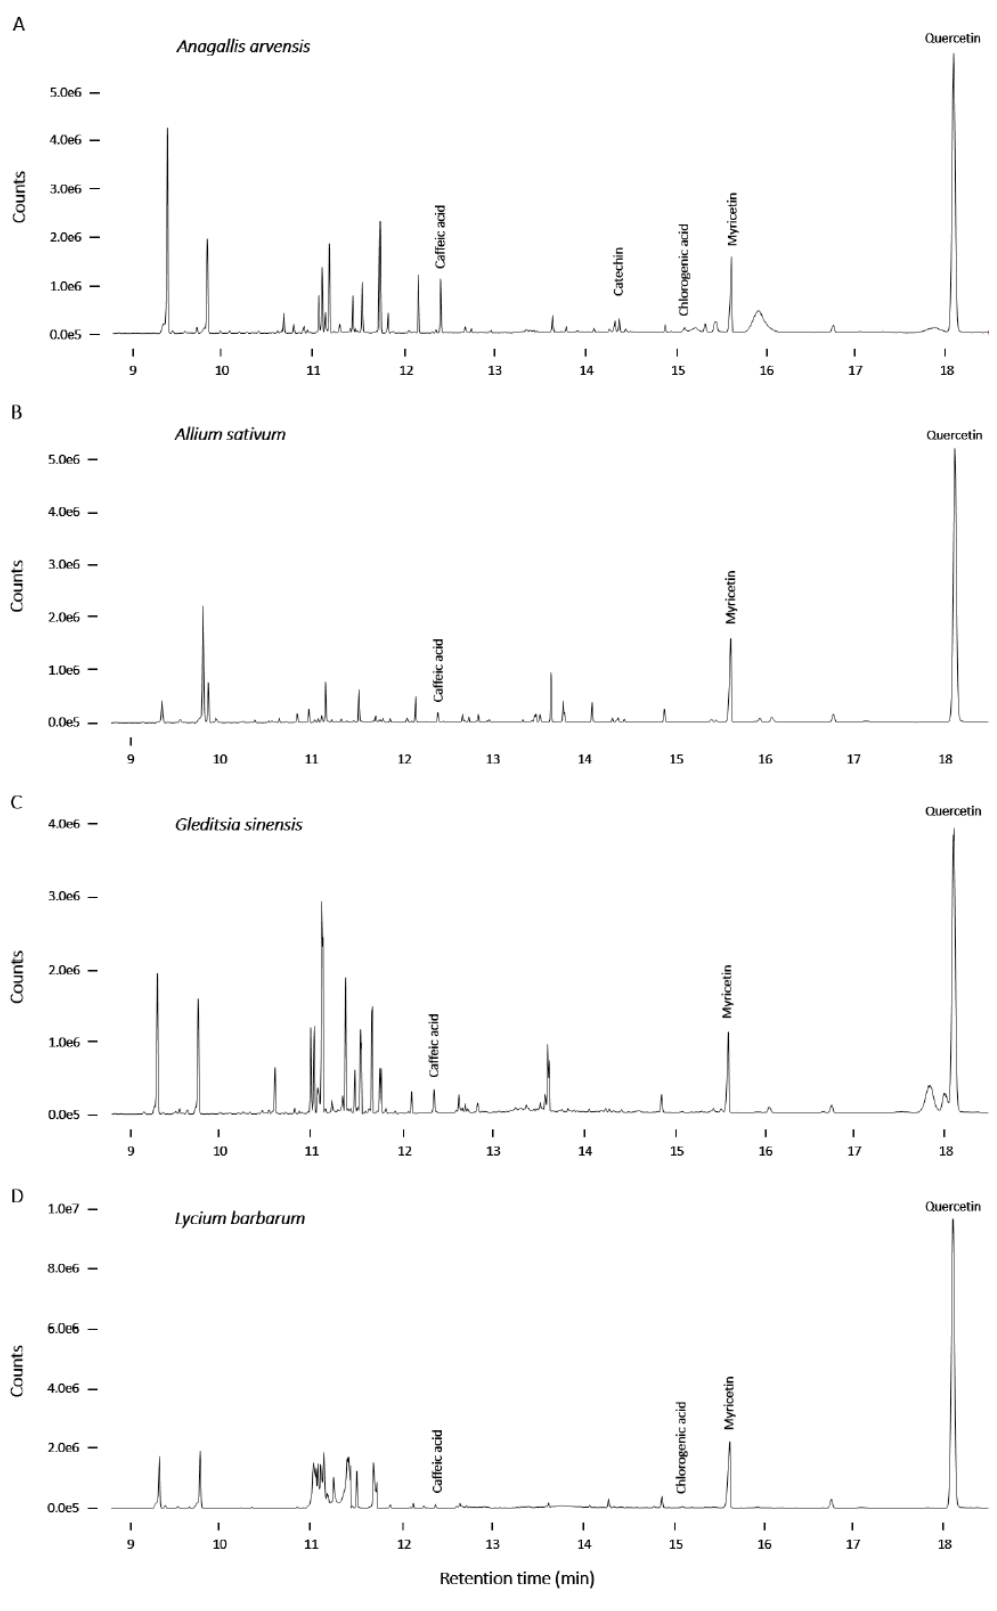
Figure A5. GC-MS chromatograms of Anagallis arvensis ( A ), Allium sativum ( B ), Gleditsia sinensis ( C ) and Lycium barbarum ( D ).